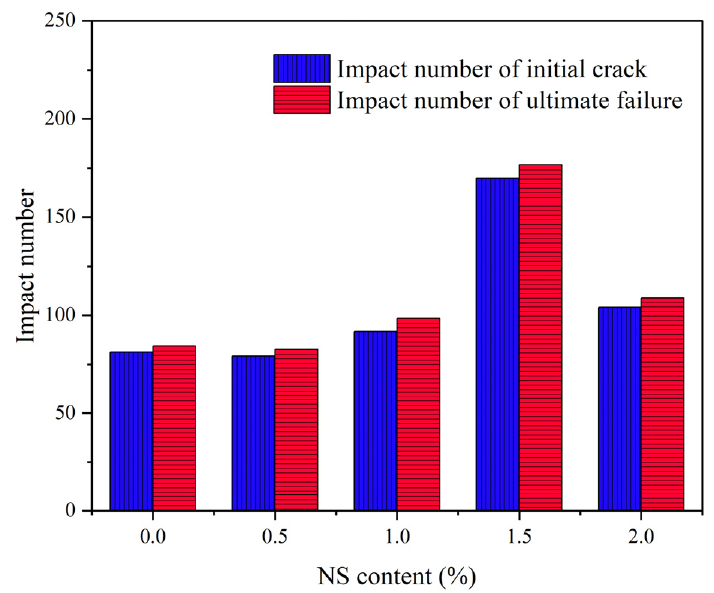
Figure 10. The influence of NS content on impact numbers.